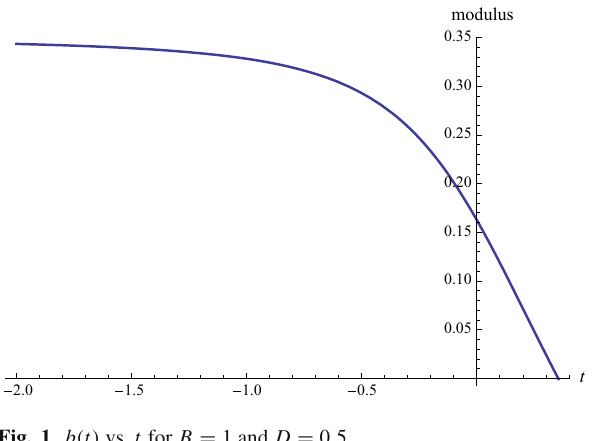
Fig. 1 b ( t ) vs. t for B = 1 and D = 0 .